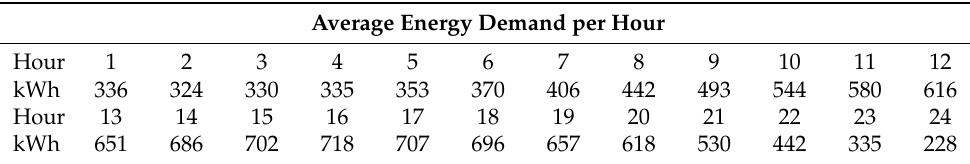
Table 4. Average total energy demand per hour per day from 5 chosen microgrids.